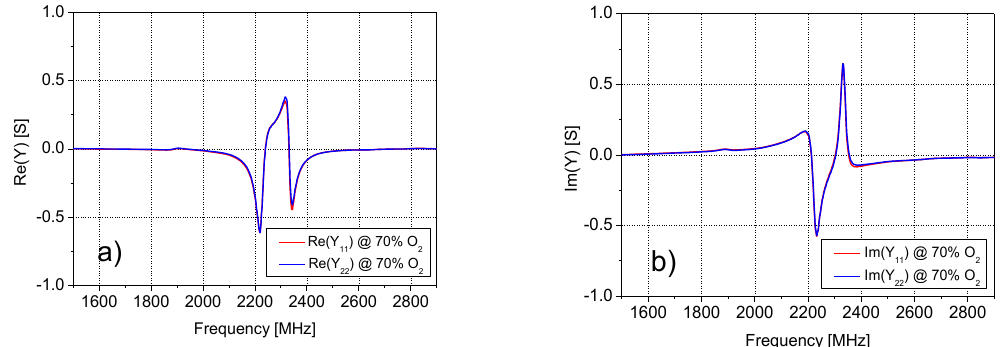
Figure 5. Frequency dependence of the ( a ) real and ( b ) imaginary parts of the impedance parameters at 70% of oxygen (O 2) concentration.